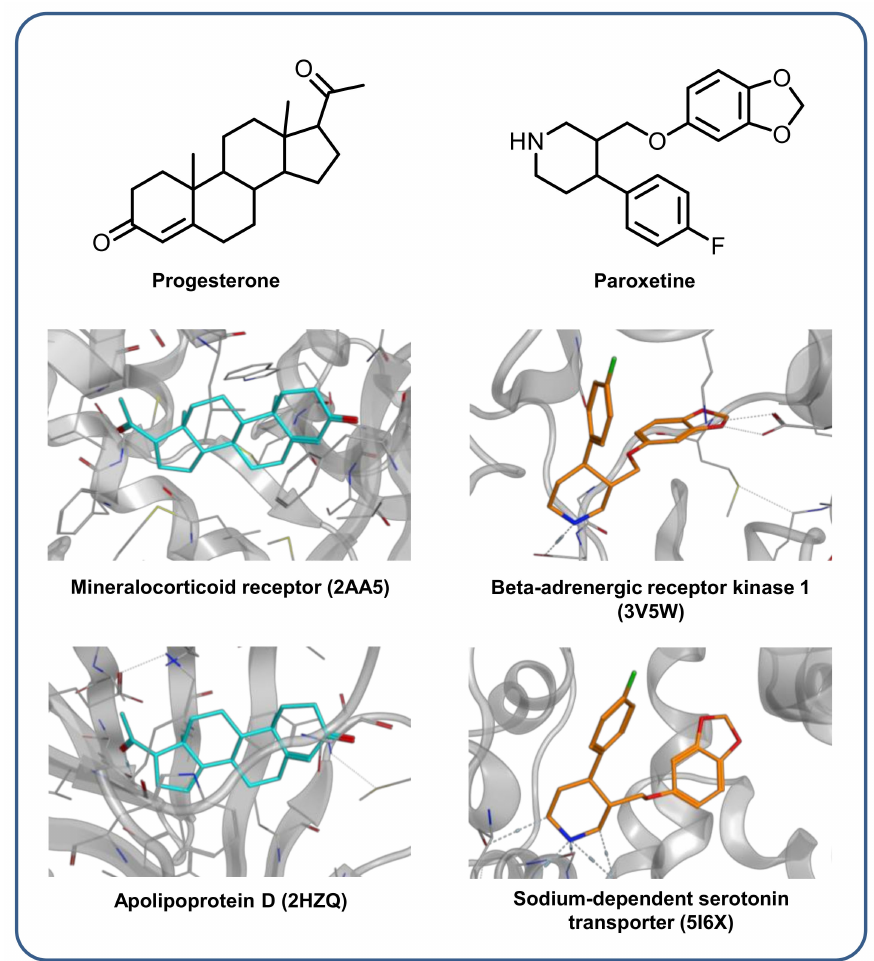
Figure 7. Exemplary X-ray structures of complexes of multiclass ligands with unrelated proteins. On the left, progesterone is bound to the mineralocorticoid receptor (PDB ID: 2AA5) and to apolipoprotein D (PDB ID: 2HZQ). On the right, paroxetine forms complexes with beta-adrenergic receptor kinase 1 (PDB ID: 3V5W) and the sodium-dependent serotonin transporter (PDB ID: